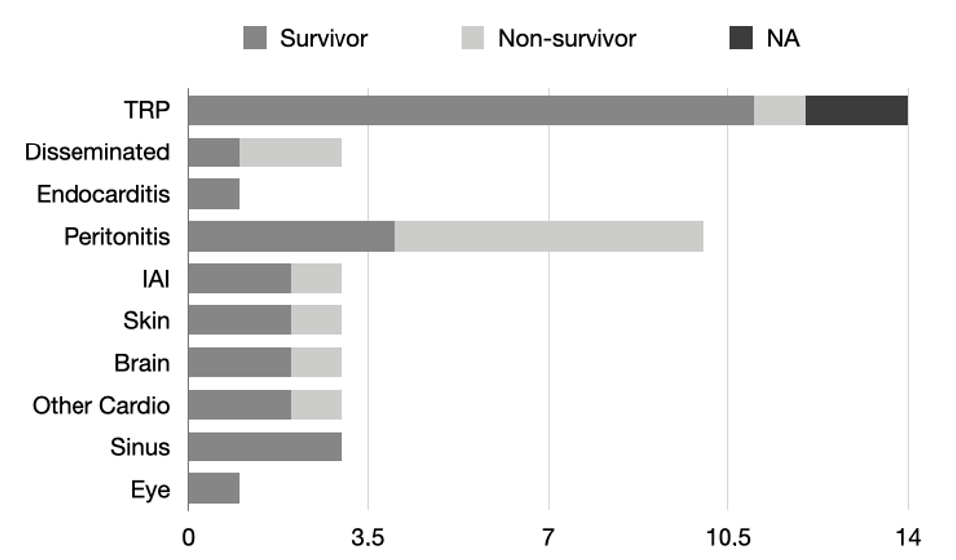
Figure 2. The graph shows the number of cases in the literature divided by type of Trichoderma infection developed by patients. Each bar is divided according to patient outcome.